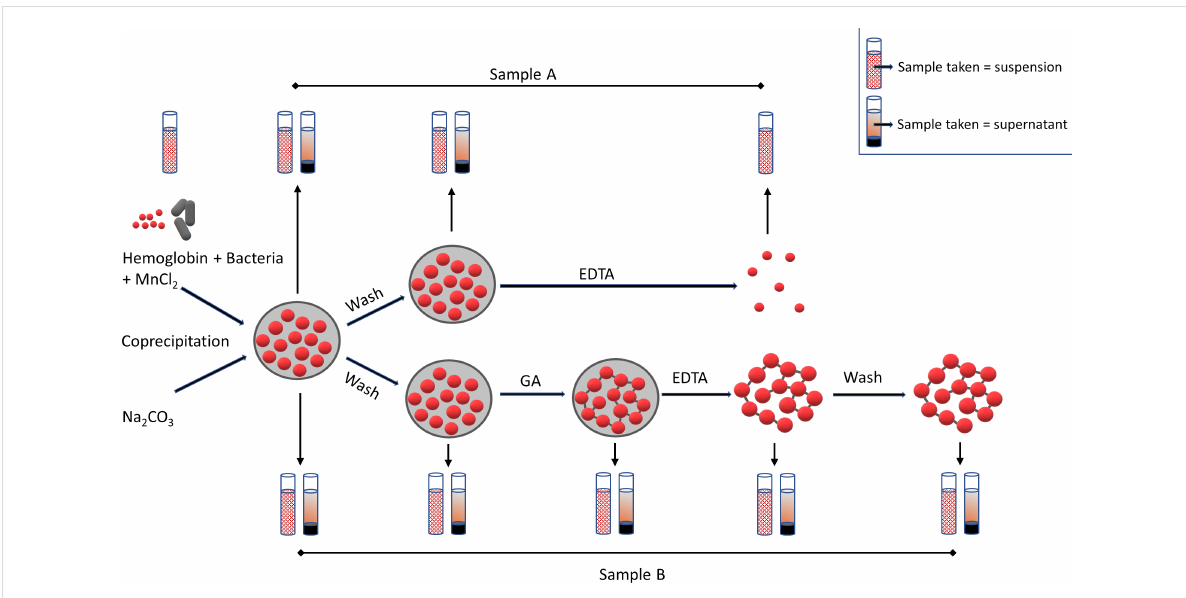
Figure 6: Simplified scheme of the experimental approach. The solution containing hemoglobin and MnCl 2 was spiked with E. coli or S. epidermidis , respectively, and coprecipitated with Na 2 CO 3 . The resulting particles were washed with NaCl and either the salt template was directly dissolved with EDTA (sample A) or the particles were cross-linked with glutaraldehyde (GA) and then dissolved with EDTA (sample B). At various production steps, the number of colony-forming units (CFU) was determined in the complete sample (suspension) and in the supernatant after centrifugation, respec-